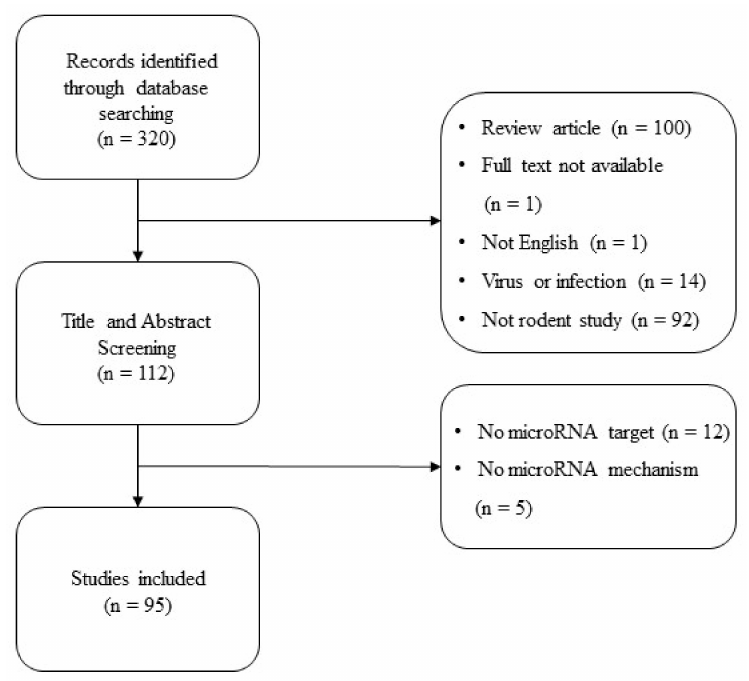
Figure 1. Flowchart of study